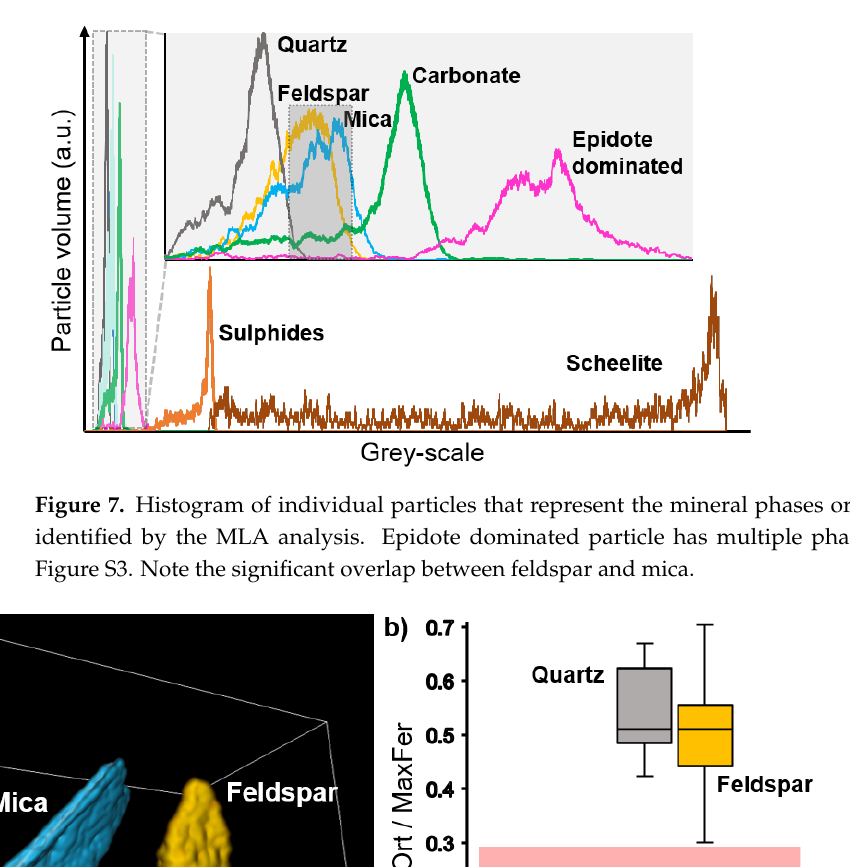
Figure 9. Overview of the correlation between a cross-section of the 3D image with the same slice analysed by electron backscattering and corresponding mineral classification by MLA of the Scheelite ore sample. The most common phases and microstructures are highlighted. 4. Discussion MSPaCMAn is founded on two interconnected ideas: (1) optimized sample prepara- tion of particle dispersions reduces imaging artefacts and eases the segmentation of indi- vidual particles; (2) phase classification is performed at the particle level, which simplifies the interpretation of the grey-scale and allows adding particle- and phase-specific prop- erties as classification criteria. Using a particle-based phase classification, the workflow proposed here is demonstrated to allow differentiating between phases that would not be distinguishable using conventional CT image analysis. The different steps of the workflow are shown to be adjustable to the specific particle system. Next, the advantages, limitations and further improvements of the different steps are discussed.